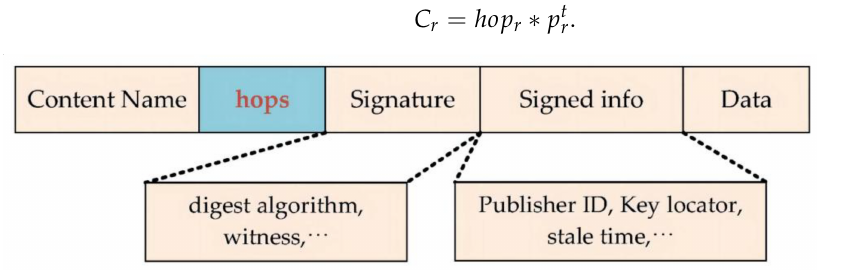
Figure 3. Data packet format (field with text in red is